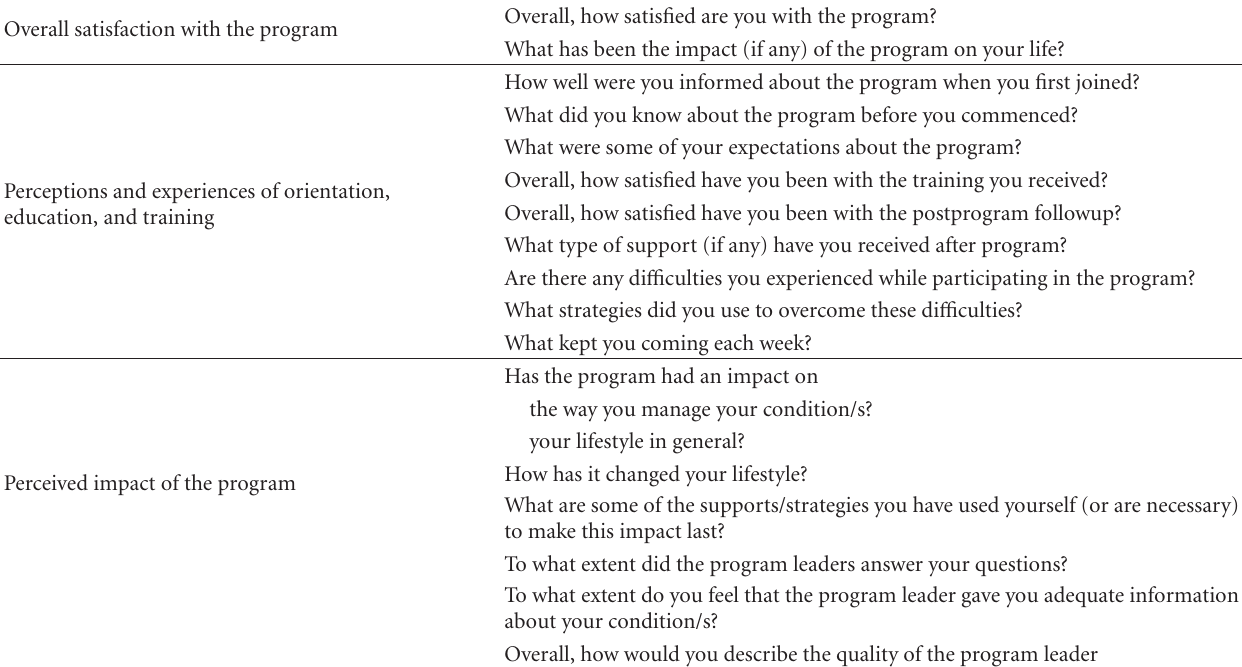
Table 2: Focus group prompt